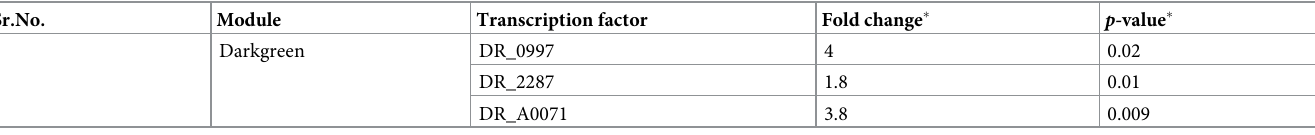
Table 2. Validation of transcription factors of modules. Sr.No.